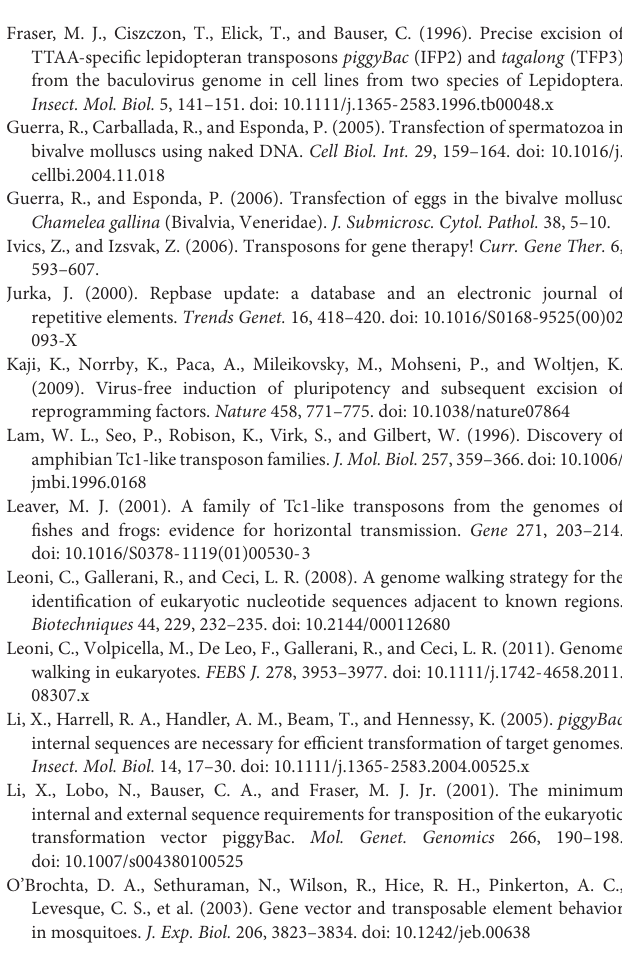
FIGURE S1 | Sequence alignment between piggyBac sequence and GFP segment amplified using the genome of the oyster transfected with piggyBac as template (PCR amplification using primers GFP-F and GFP-R). FIGURE S2 | Sequence alignment between piggyBac-gGH sequence and GH segment amplified using the genome of the oyster transfected with piggyBac-gGH as template (PCR amplification using primers GH-F and GH-R). FIGURE S3 | Sequence alignment between piggyBac-gGH sequence and GH-GFP segment amplified using the genome of the oyster transfected with piggyBac-gGH as template (PCR amplification using primers GH-GFP-F and GH-GFP-R). The sequence at upstream of the first red arrow is GH segment, that between the two red arrows is the partial plasmid sequence, and that at downstream of the second red arrow is GFP